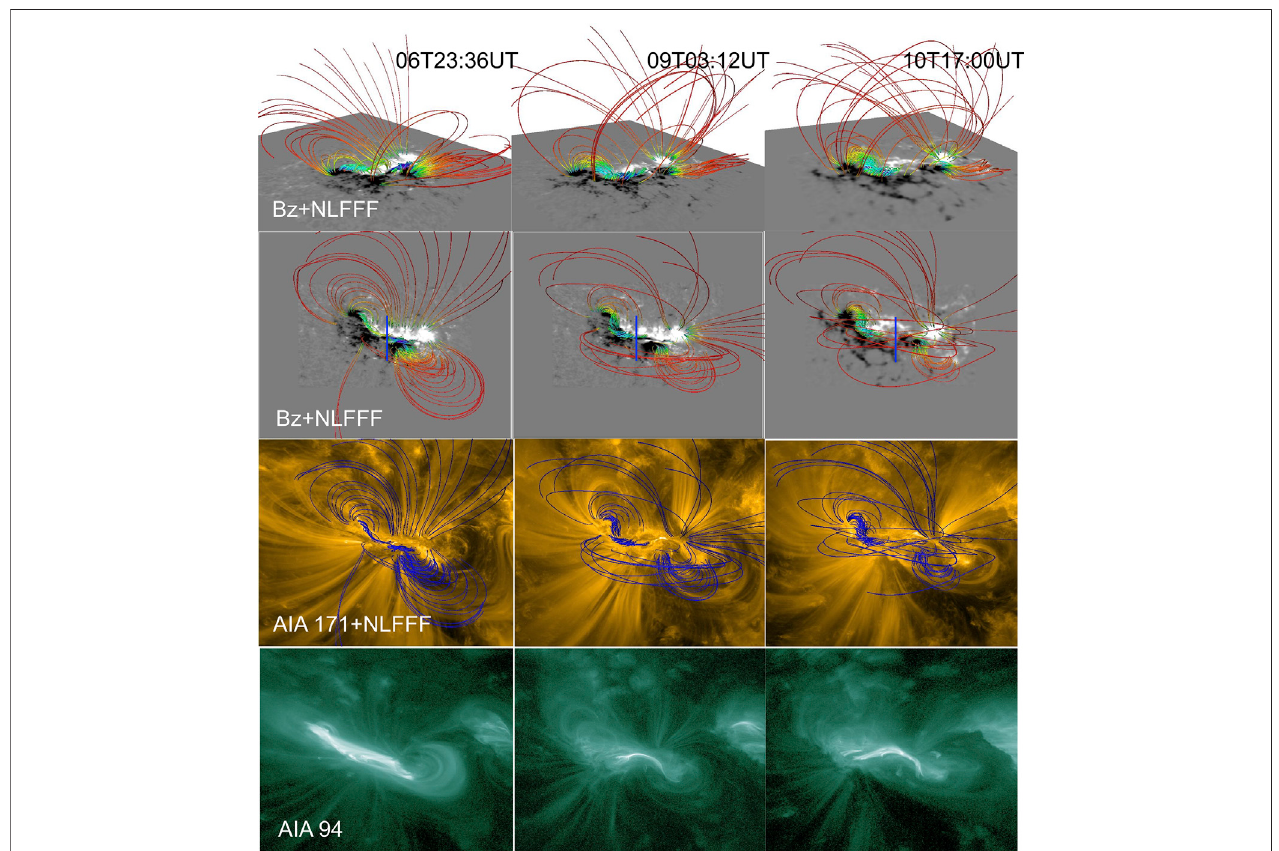
FIGURE 4 | Pre-eruptive magnetic structure modeled by NLFFF in the AR 11429 for the three CME events. First row: Perspective view of the fi eld-line rendering. Bottom image is photospheric magnetogram ( B z ). Twisted structure along the PIL is overlaid by the less sheared fi eld lines Second row: fi eld lines plotted on top of the photospheric magnetogram (Bz). The global structure is asigmoid withtwo opposite-J-shaped loops and an inner core ofhighly twisted fi eld. Vertical blue lines indicate the location of the slice plane for QSL analysis. Third row: same fi eld lines on AIA 171 Å images, Fourth row: AIA 94 Å images at the same time. Hot plasma emission is mainly co-spatial with the strongly sheared core along the PIL. To a good approximation, the modeled structure resembles the coronal plasma loops in the EUV images. Field lines are color coded (blue (red): 1,200 (2)G) with the horizontal fi eld strength in height in fi rst and second rows.